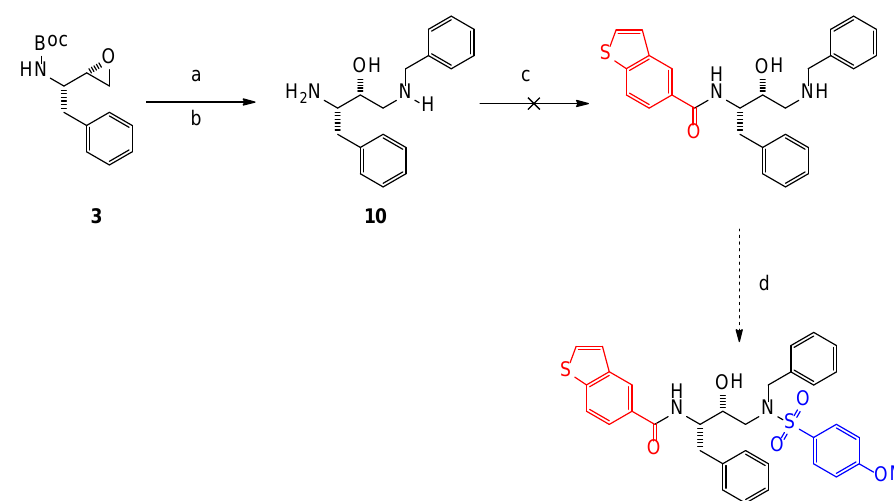
(Table 1) [13–18]. The initial rates of the enzyme-catalyzed reactions were measured at different inhibitors concentrations, while the reference rates for the not-inhibited reactions were measured each time before the addition of the inhibitors. IC50 was obtained by measuring the relative residual enzyme activity (ratio of the increase of fluorescence ve- locities before and after the addition of inhibitor) and by fitting the residual activity vs. inhibitor concentration semilog plots to a tetraparametric logistic function. The results are the mean of three independent experiments and are reported in Table 1, while the plots are reported in Supplementary Figure S1. Table 1. In vitro inhibition activity of compounds 7 . Table 1. In vitro inhibition activity of compounds 7